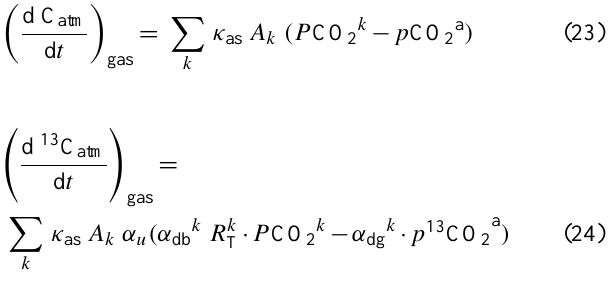
Fig. 3. Schematic illustration of carbonate and silicate weathering fluxes. Numbers in parentheses indicate steady-state fluxes of TCO 2 and TA in mole per mole of CaCO 3 or CaSiO 3 weathered.